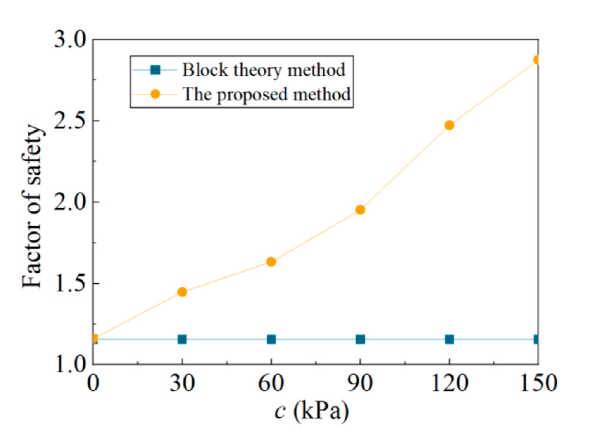
FIGURE 5 Effect of the cohesion of discontinuities ABED and ACFD on